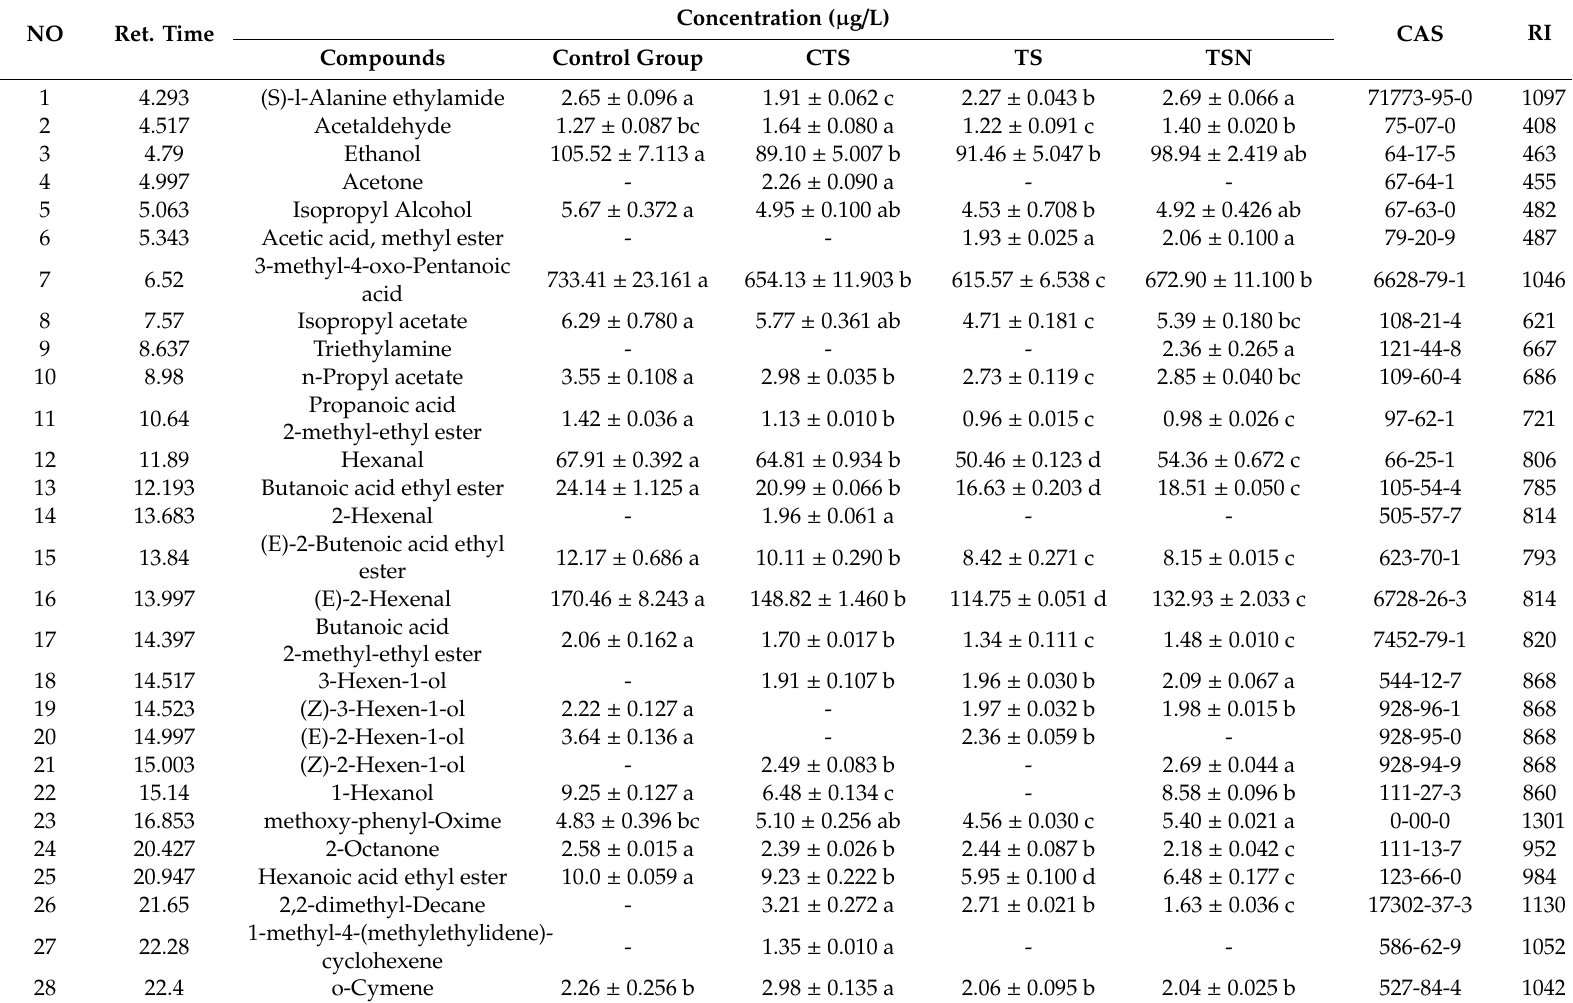
Table 2. The variety and concentration of the volatile compounds in grape juice under di ff erent sterilization